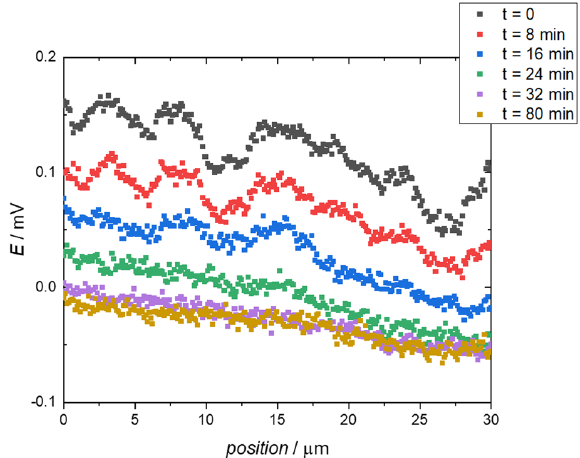
Fig. 8 Surface potential pro fi les extracted from the maps on the sample 10C-1.5O. Surface potential ( E ) vs. horizontal axis position, extracted from the SKPFM images in Fig. 7 at a vertical axis position of 18 μ